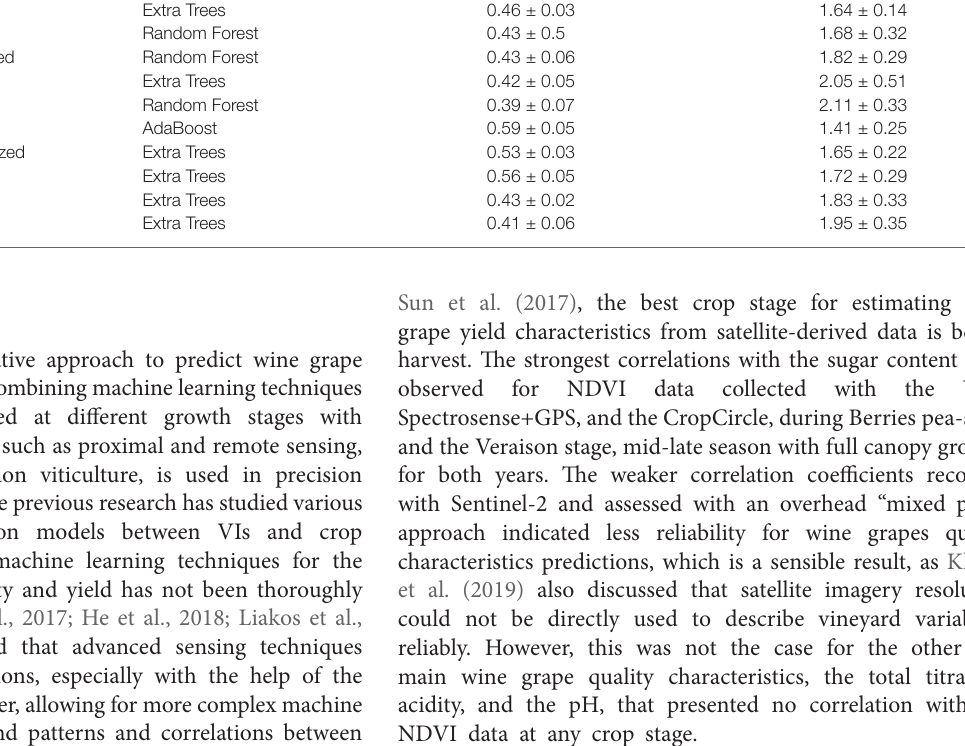
TABLE 5 | Selected best performed nonlinear regression models performed using the highly correlated NDVI data from all four proximal and remote sensors to evaluate their performance in assessing the wine grapes quality characteristics (legend as for Table 3 ). Sensor_growth